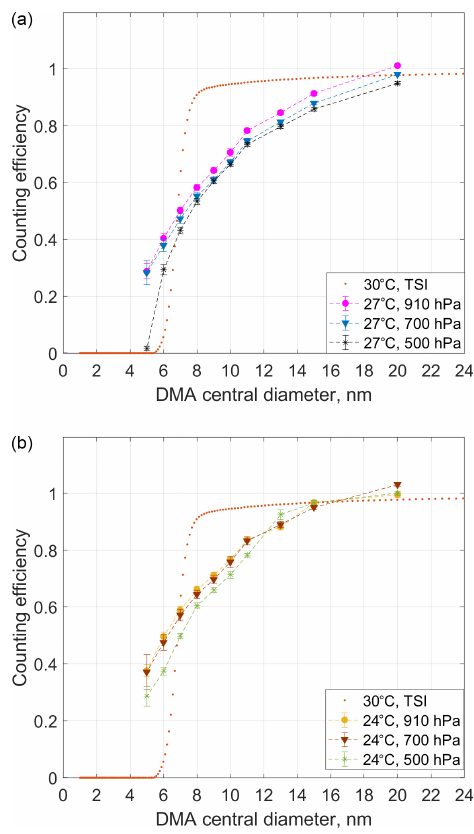
Figure 9. The vWCPC 3789 counting efficiency changes as a func- tion of the different operating pressures (500, 700, and 910hPa) us- ing AS particles when the initiator temperature is 59 ◦ and the mod- erator temperature is 10 ◦ at two different conditioner temperatures of (a) T cond = 27 and (b) T cond = 24 ◦